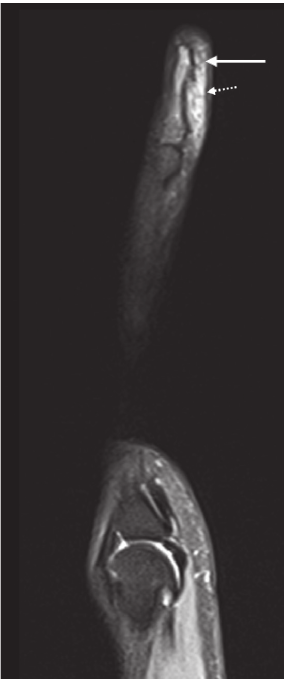
Figure 13: Artefact. Sagittal PDFS of the ring finger of a healthy volunteer demonstrating a failure of fat suppression at the tip of the finger resulting in a false impression of marrow hyperintensity in the distal phalanx. The adjacent subcutaneous tissue is also in- adequately suppressed (dash).